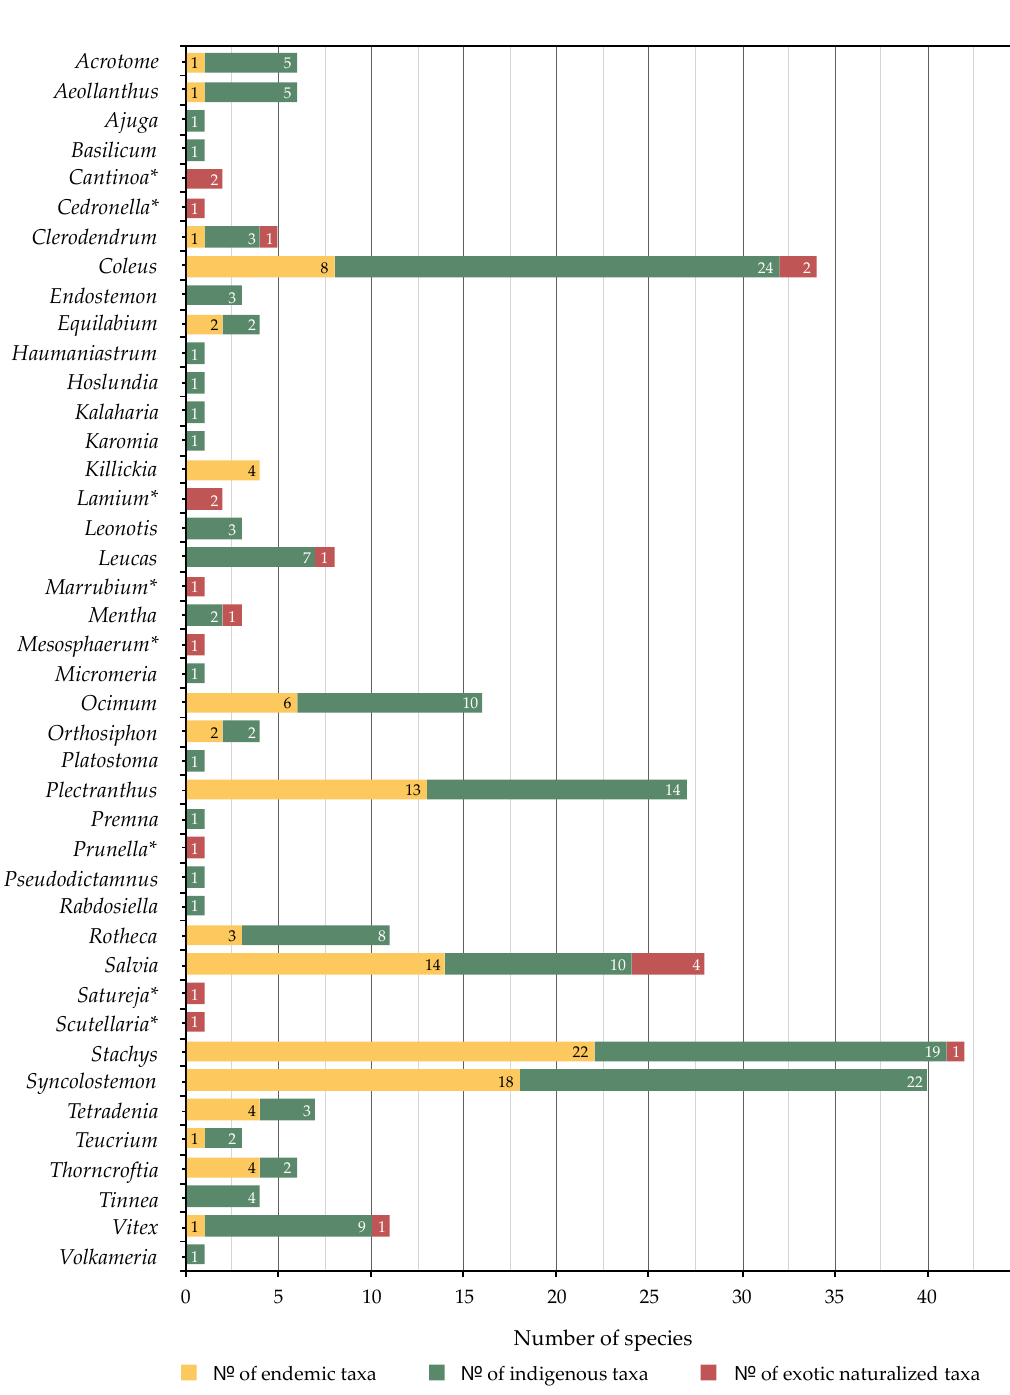
Figure 3. The genera and number of species (endemic, indigenous and naturalized) within southern African Lamiaceae. The last taxonomic account of southern African Lamiaceae was by Codd in 1985 and included 232 species within 37 genera [17]. Since then, many studies have produced nomenclatural changes, resulting in the movement of one genus to another, or members from one family moved to another, based on molecular data. Several studies illustrate this, including the renaming of many Plectranthus species to Coleus [18], Becium Lindl. to Ocimum L. [19], Hemizygia (Benth.) Briq. to Syncolostemon [20], and members of other families (such as Verbenaceae J. St.-Hil.) being moved to Lamiaceae [21,22], thus making it difficult to find an up-to-date account of Lamiaceae species for the region.